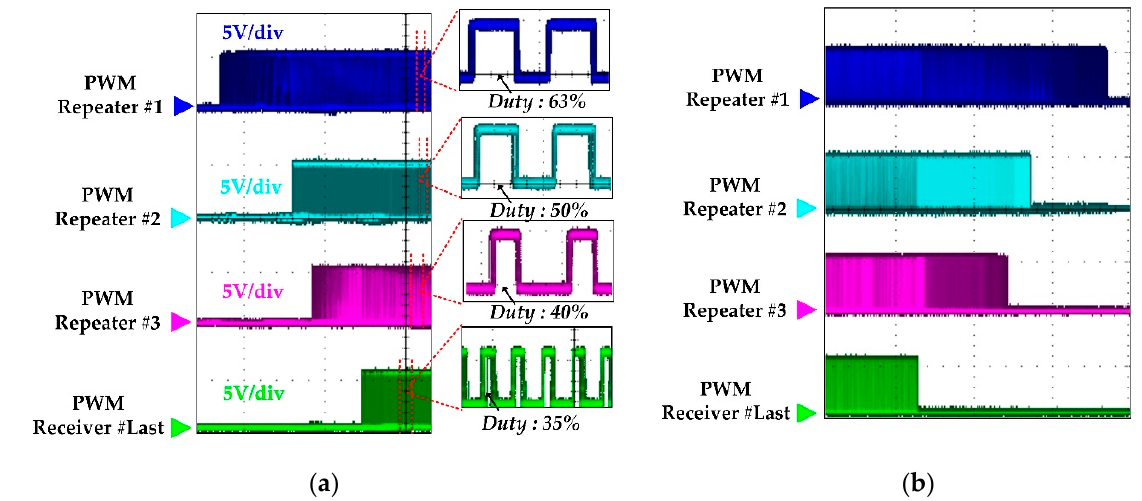
Figure 15. Sequence of repeater regulation for proposed multi-load WPT relay system when TX power ( a ) increases and ( b ) decreases.